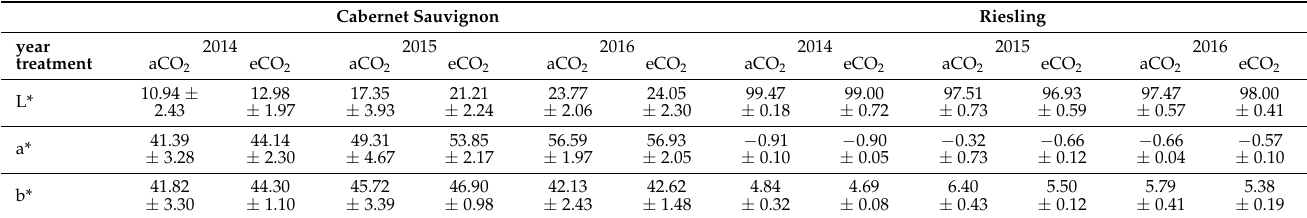
Table 4. CIELab parameters of cvs. Cabernet Sauvignon and Riesling young wines at two CO 2 levels (aCO 2 and eCO 2 ) after fermentation of 2014, 2015 and 2016.